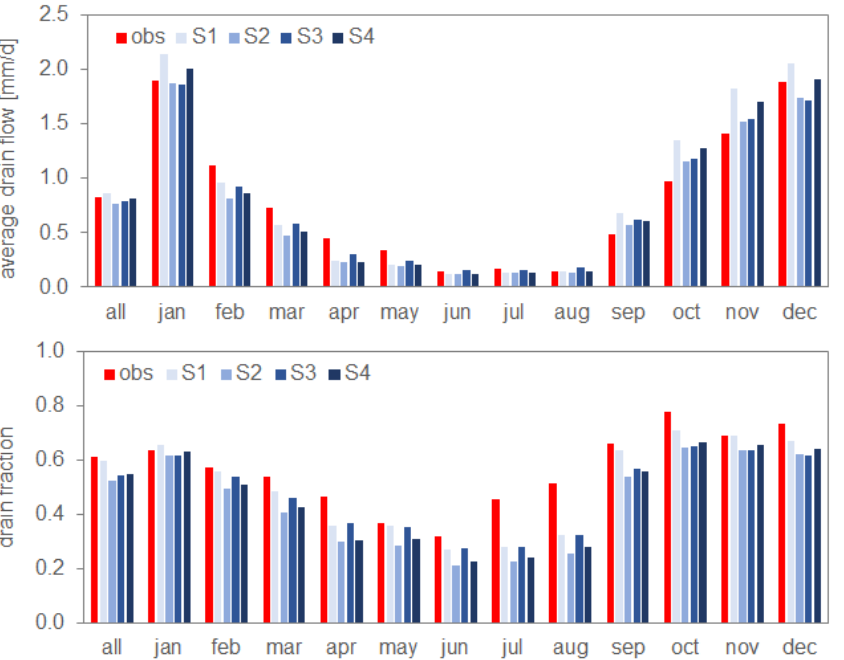
Figure 6. Drain flow and drain fractions (drain flow/total flow) in the Fensholt sub-catchment for the four scenarios compared to the observation-based estimate. Average values across the evaluation period.